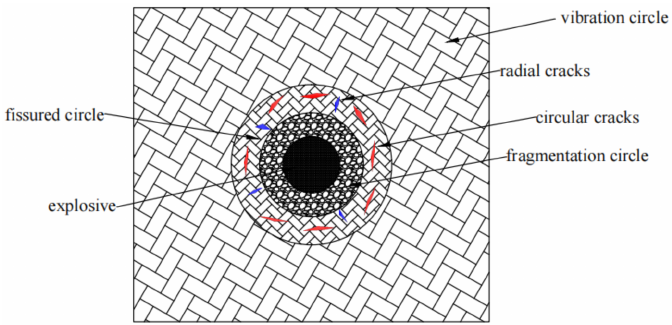
Figure 1. Diagram of rock blasting mechanism.